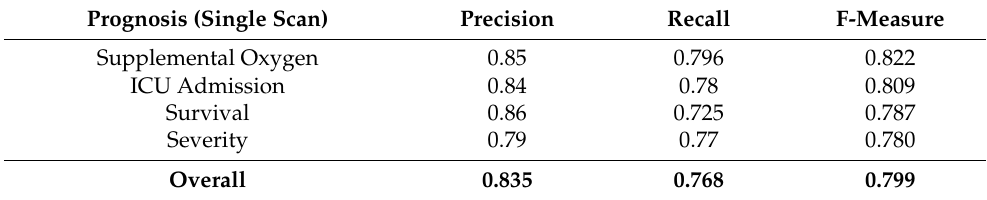
Table 3. Prediction performance of the proposed method using single scan per patient (both datasets). Prognosis (Single Scan) Precision Recall F-Measure Supplemental Oxygen 0.85 0.796